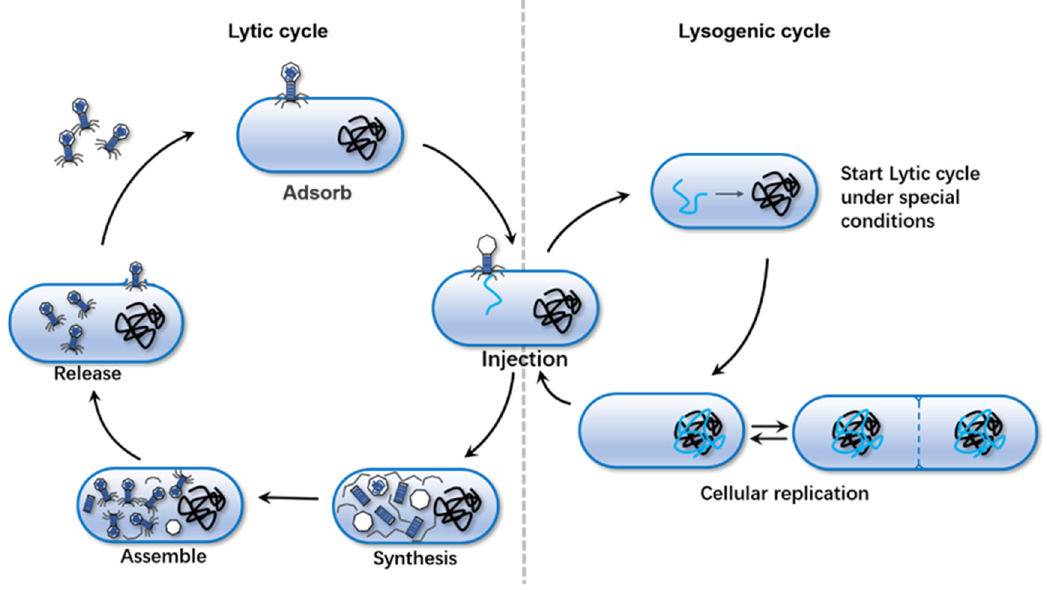
Figure 1. Phage lysis cycle and lysogenic